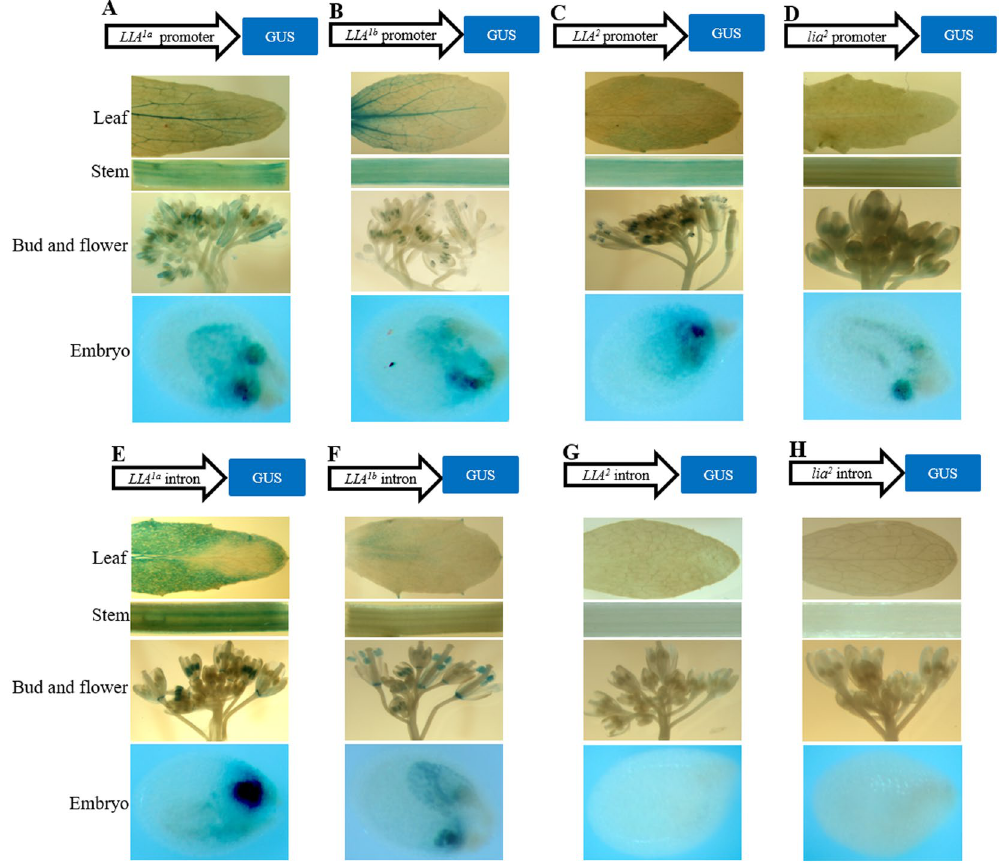
Figure 5. Histochemical localization of GUS activity in the leaf, stem, bud and flower, and 7d old embryo of transgenic Arabidopsis plants containing the construct pBI101- LIA 1a -promoter-GUS with the promoter of LIA 1a ( A ), pBI101- LIA 1b -promoter-GUS with the promoter of LIA 1b ( B ), pBI101- LIA 2 -promoter-GUS with the promoter of LIA 2 ( C ), pBI101- lia 2 -promoter-GUS with the promoter of lia 2 ( D ), pBI101- LIA 1 a -intron-GUS with the intron of LIA 1 a ( E ), pBI101- LIA 1b -intron-GUS with the intron of LIA 1b ( F ), pBI101- LIA 2 -intron-GUS with the intron of LIA 2 ( G ) and pBI101- lia 2 -intron-GUS with the intron of lia 2 ( H ), respectively. GUS staining was observed in the figures A, B, C, D, E and F, but not in the figures G and